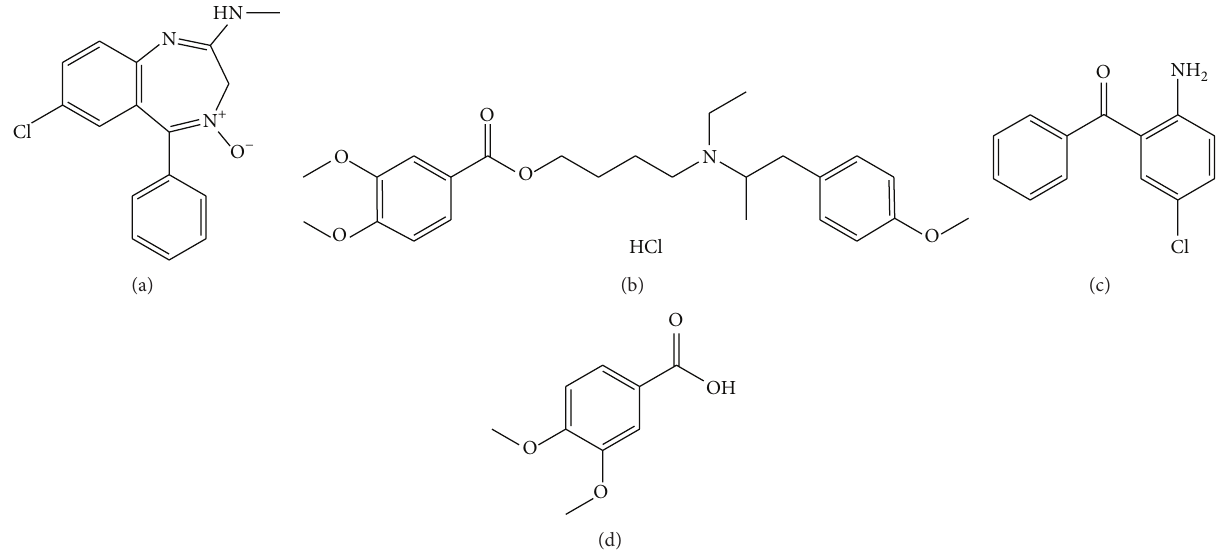
Figure 1: Structural formulas of (a) chlordiazepoxide, (b) mebeverine HCl, (c) 2-amino-5-chlorobenzophenone, and (d) veratric acid.